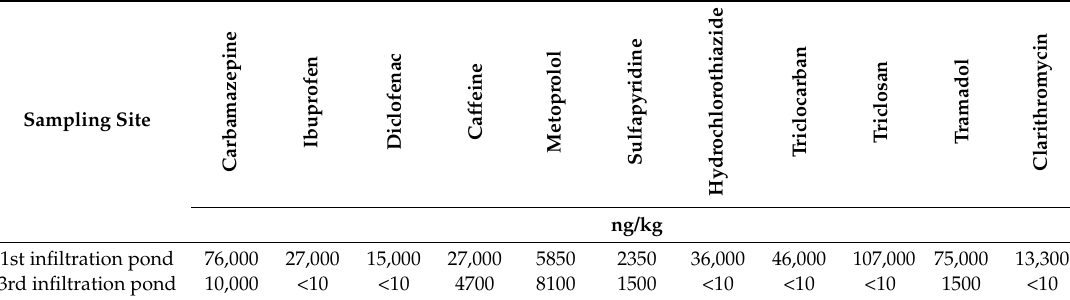
Table 6. Detected pharmaceutical concentrations in the mud of the infiltration ponds.